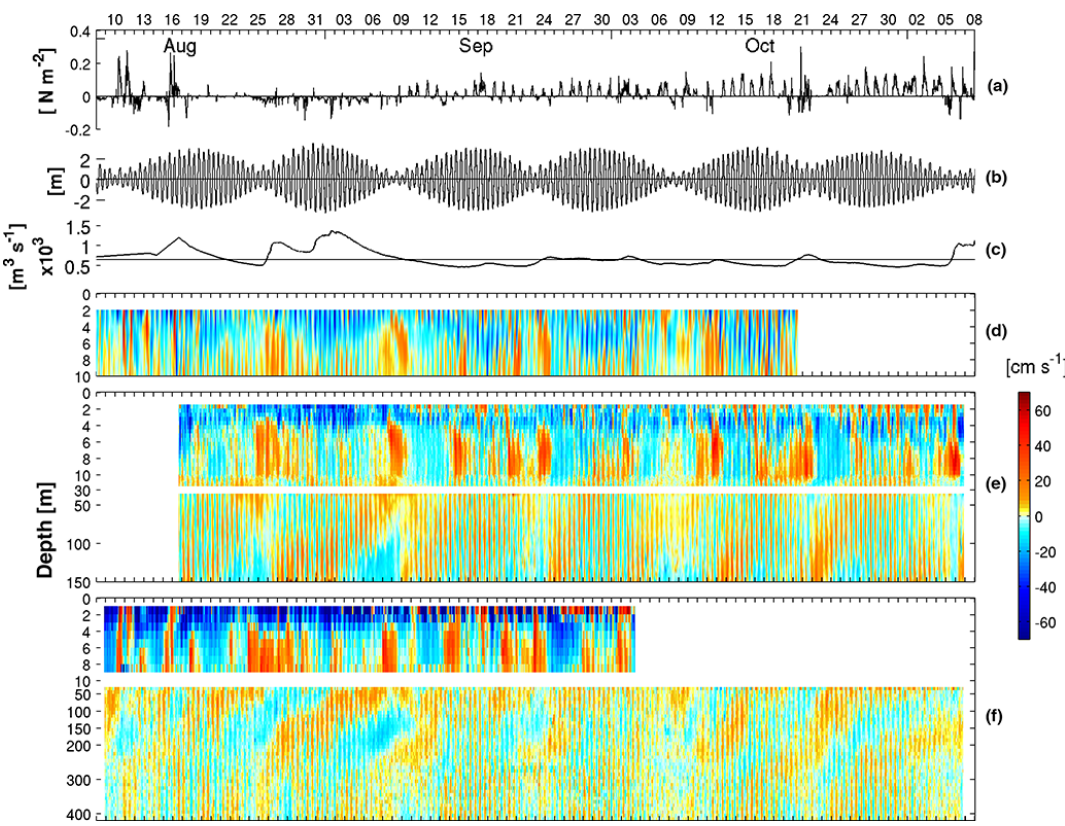
Figure 3. (a) Along-fjord wind stress, positive up to the fjord, (b) sea-level, and (c) Puelo River discharge, where the straight line represents the long-term mean. Contours of along-fjord currents at (d) Cochamo, (e) Puelo, and (f) the mouth; in the filled contours, the blue (red) colors indicate a net outflow